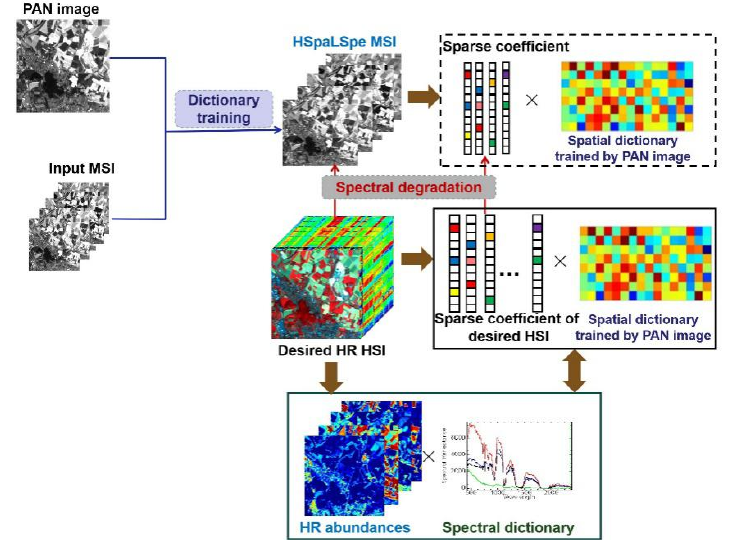
Figure 2. A spatial observation model.